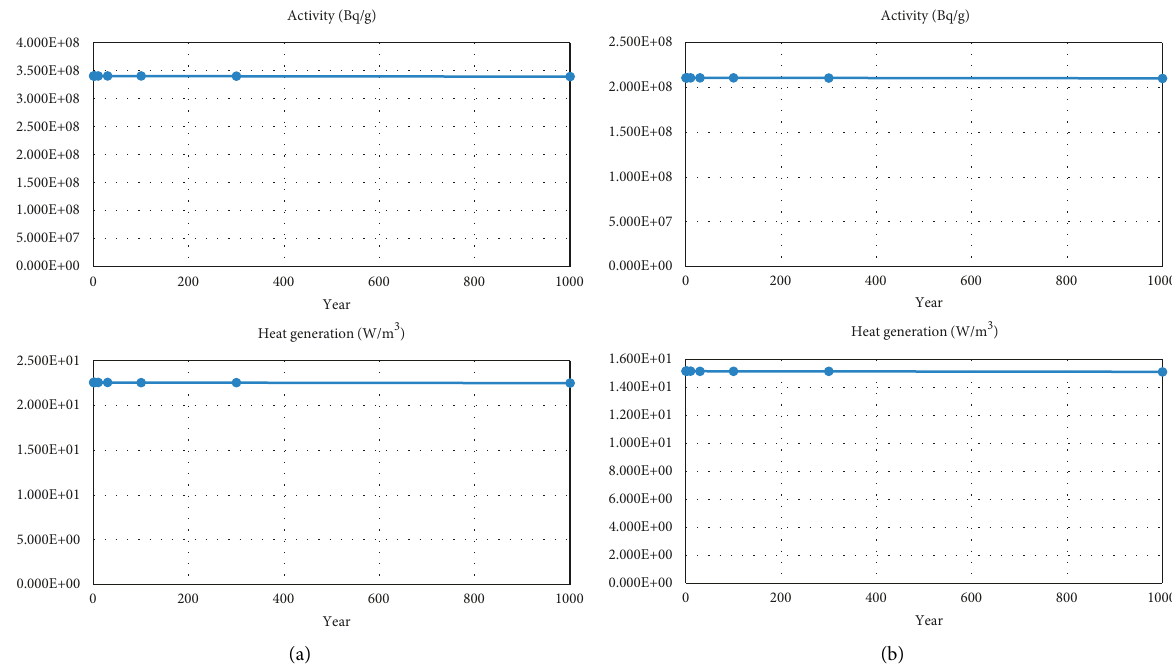
Figure 9: Radiological characteristics of Tc waste/waste form. (a) Ca(ReO